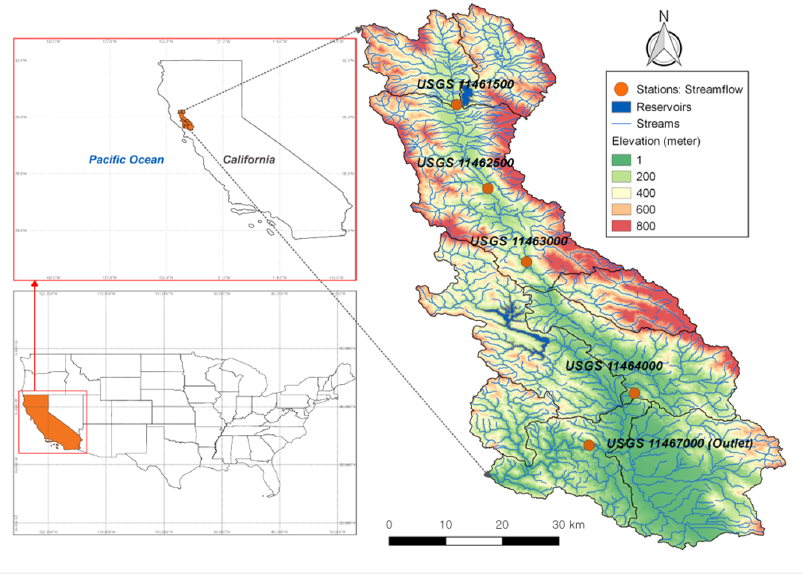
Figure 1. The Russian River basin, California. Orange points represent five runoff stations located in the basin. the